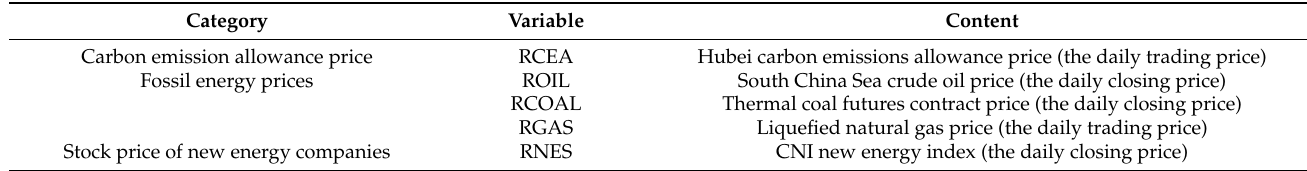
Table 1. Introduction of variables and